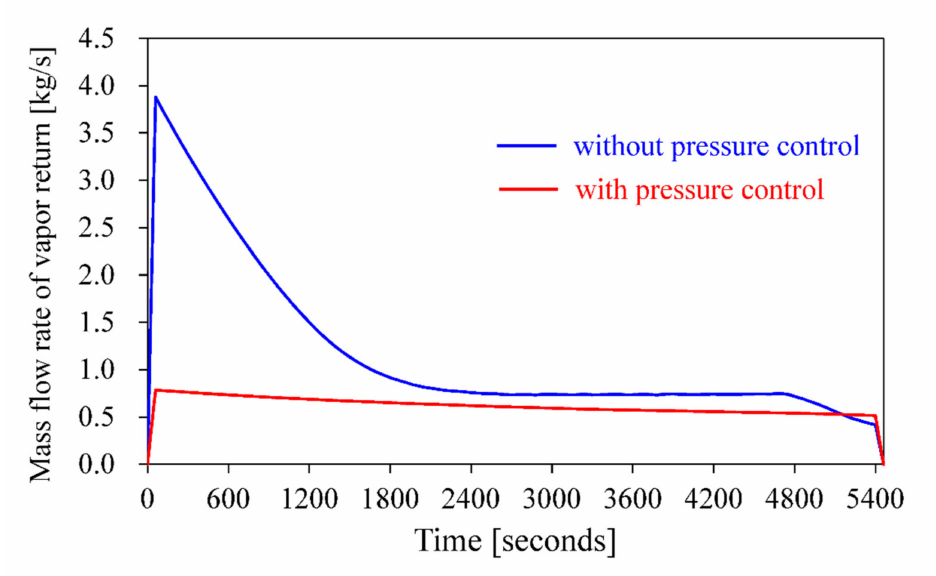
Figure 11. Variation of tank pressure with time (solid line: bunker tank, dotted line: receiving tank).